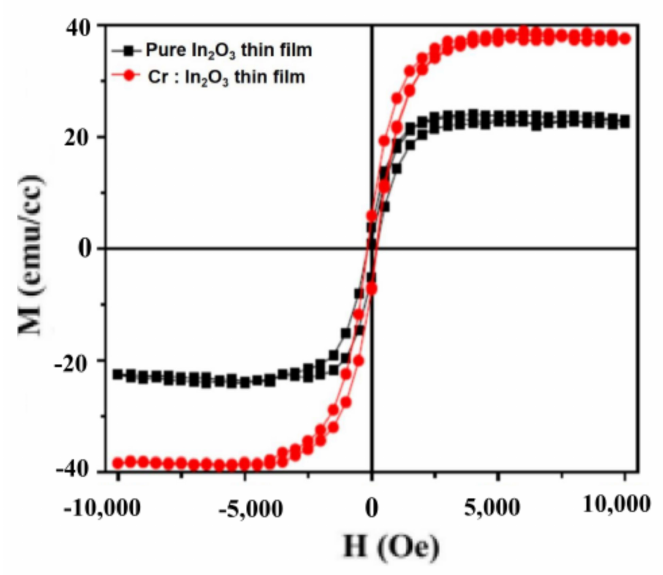
Figure 5. M-H curves of pure In 2 O 3 and Cr doped In 2 O 3 thin films measured at room temperature.